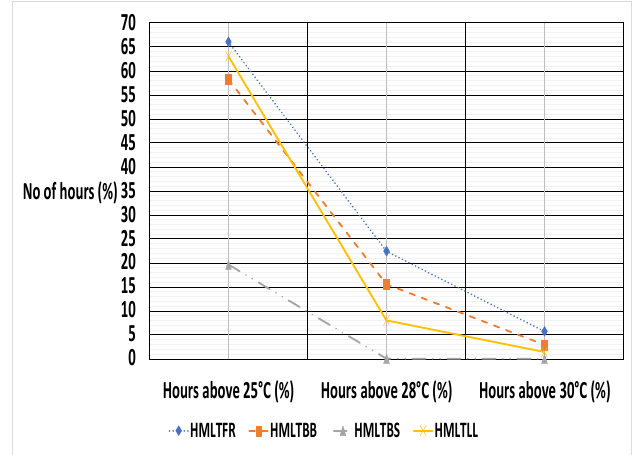
Figure 5. Number of hours of temperatures that exceed the temperatures in the case studies. Table 6. Summary of the average variables and thermal indices in the case studies.